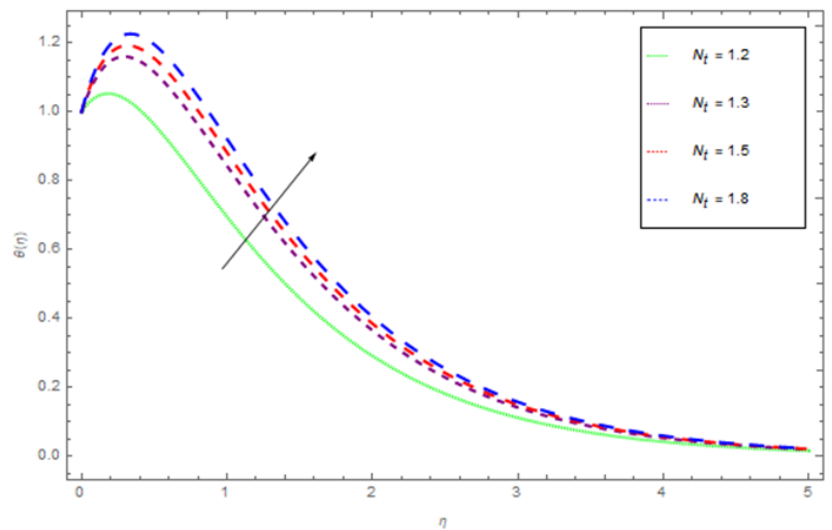
Figure 7. The influence of